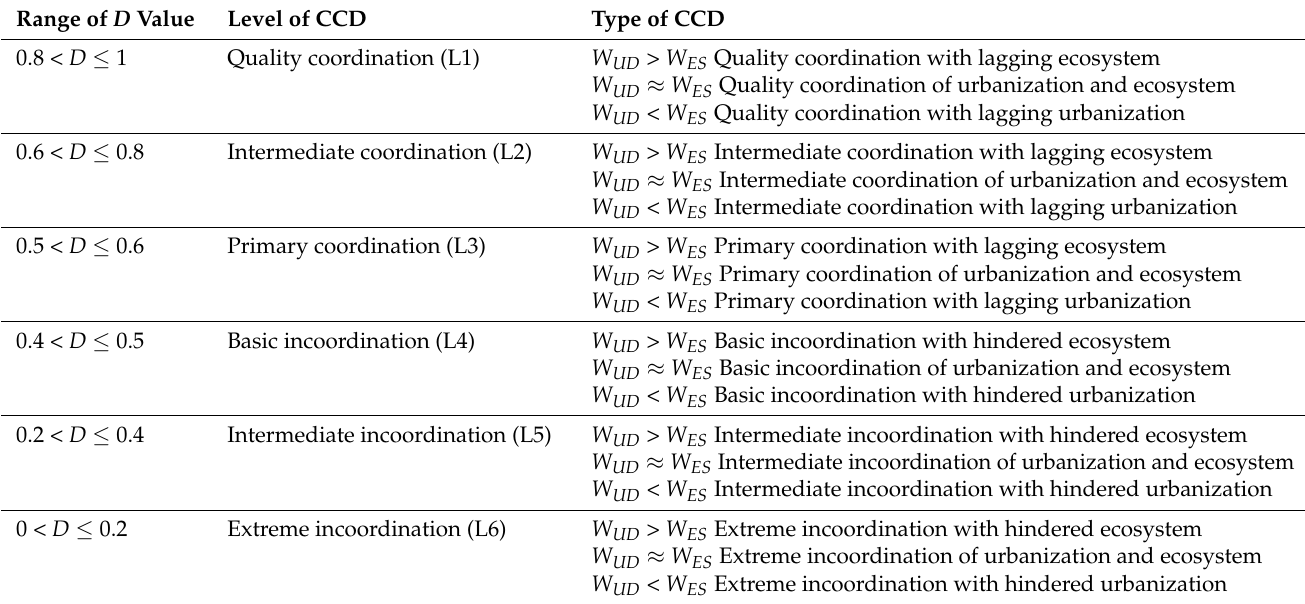
Table 2. CCD standard between ESV and